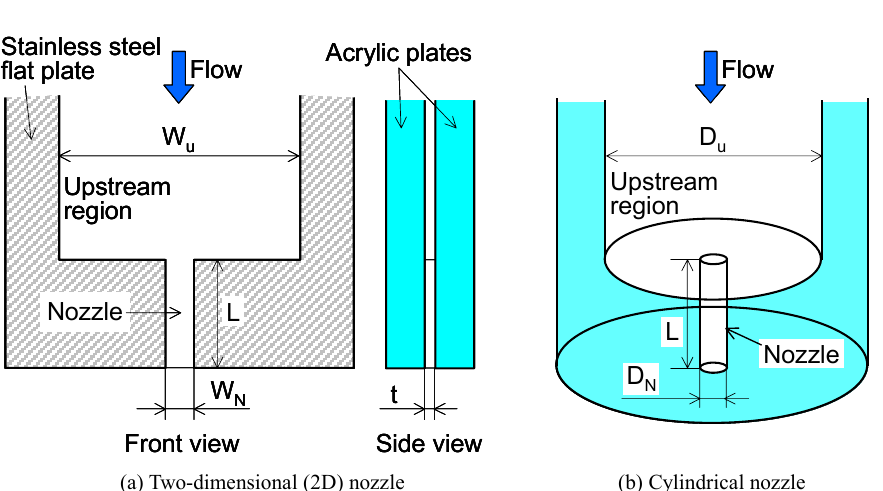
Fig. 1 Experimental setup